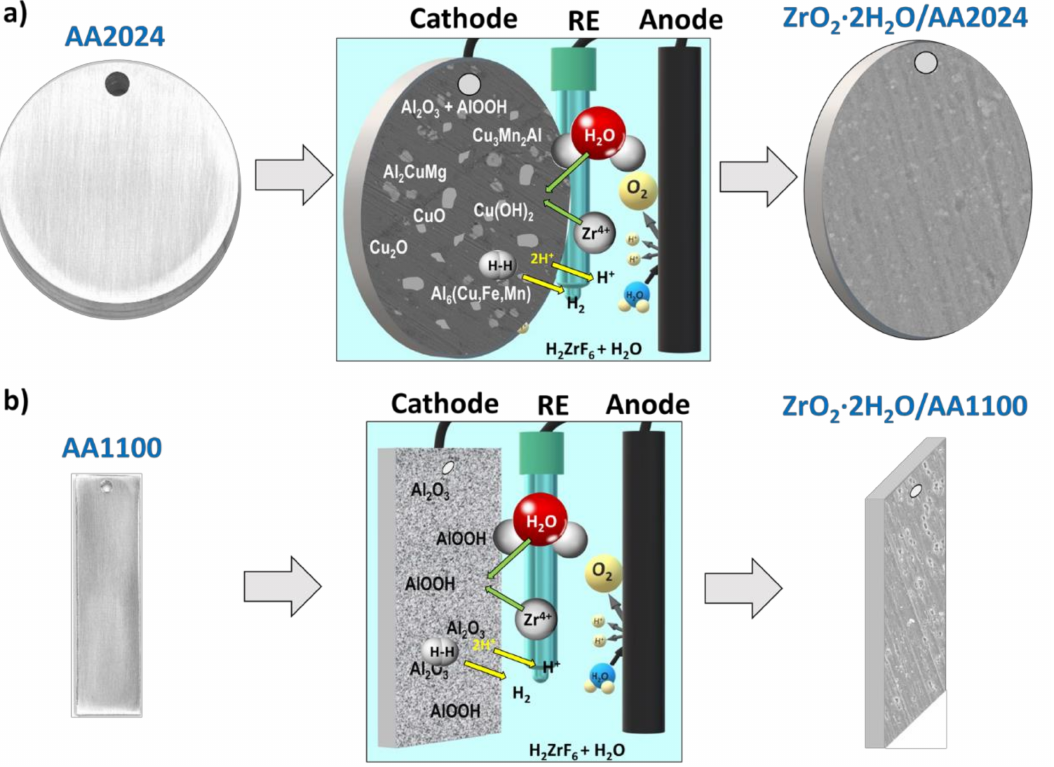
Scheme 1. Illustration of the best conditions for Zr-EAD deposition on: ( a ) AA2024 disks and ( b ) AA1100 aluminum plates. From left to right: Bare substrates; application of − 1.0 V of cathodic potential and 4 min of electrochemical reaction; Zr-EAD coated specimen. Arbitrary scale has been used for the visual representation of the